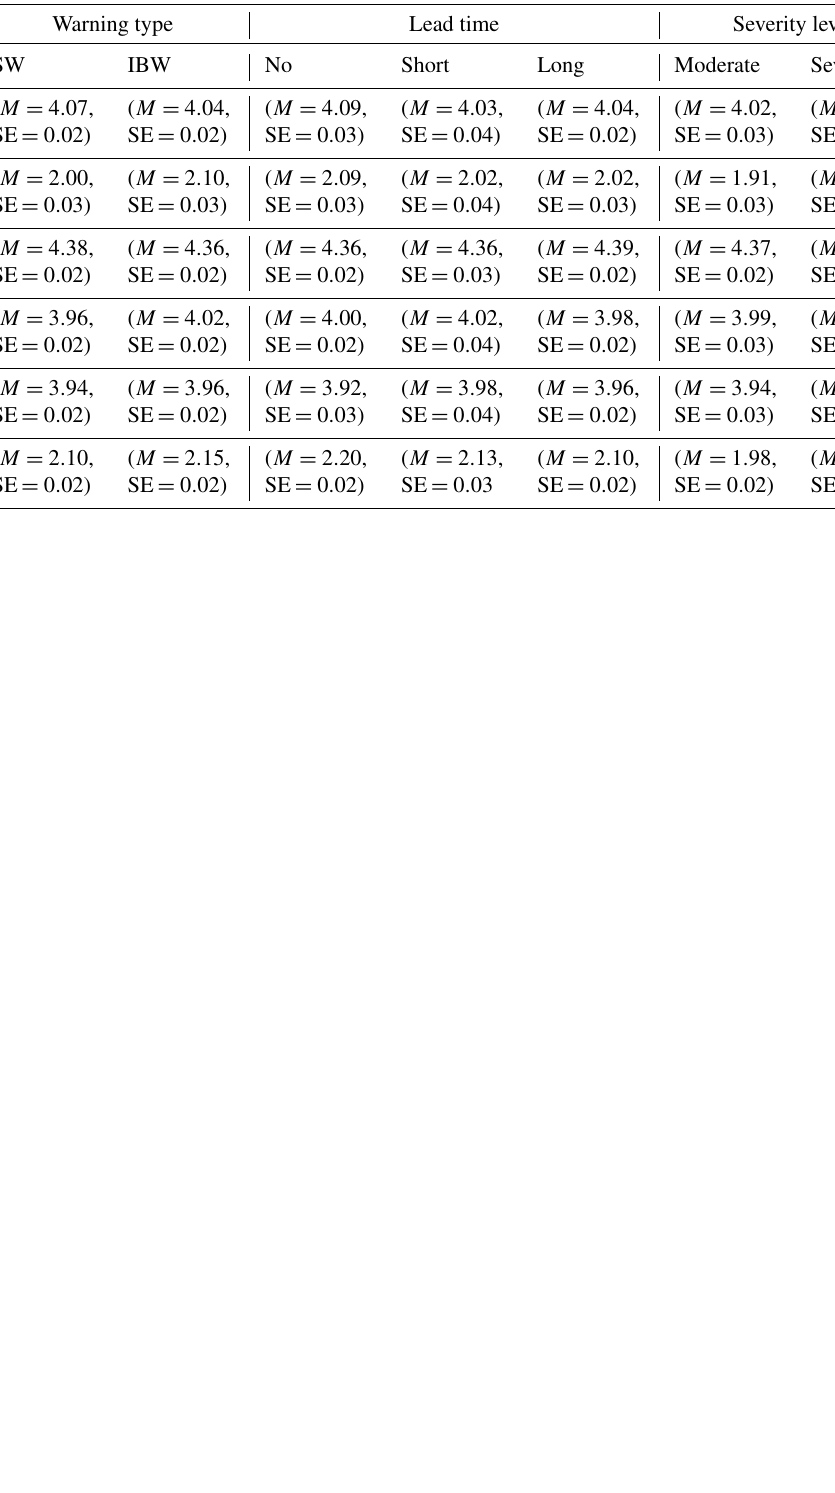
Table A1. Descriptive statistics. M is mean, and SE is standard error. Variables were measured on a five-point scale from 1 (totally disagree) to 5 (totally